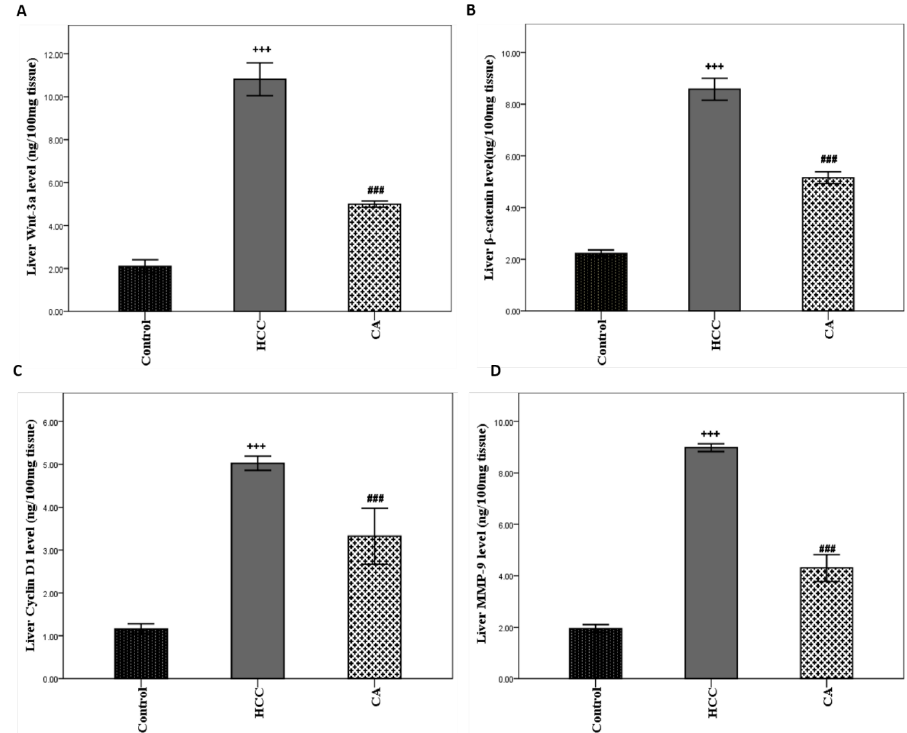
Figure 5. Effect of CA on hepatic ( A ) Wnt-3a, ( B ) β -catenin, ( C ) Cyclin D, and ( D ) MMP-9 protein levels. Data were expressed as mean ± S.E.M. Ten rats in each group. +++ p < 0.001 vs. control group, ### p < 0.001 vs. HCC group.